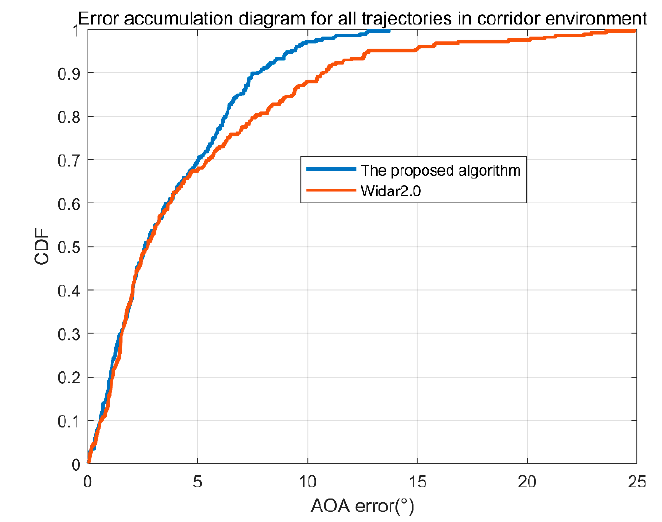
Figure 11. Cumulative angle error of the corridor.